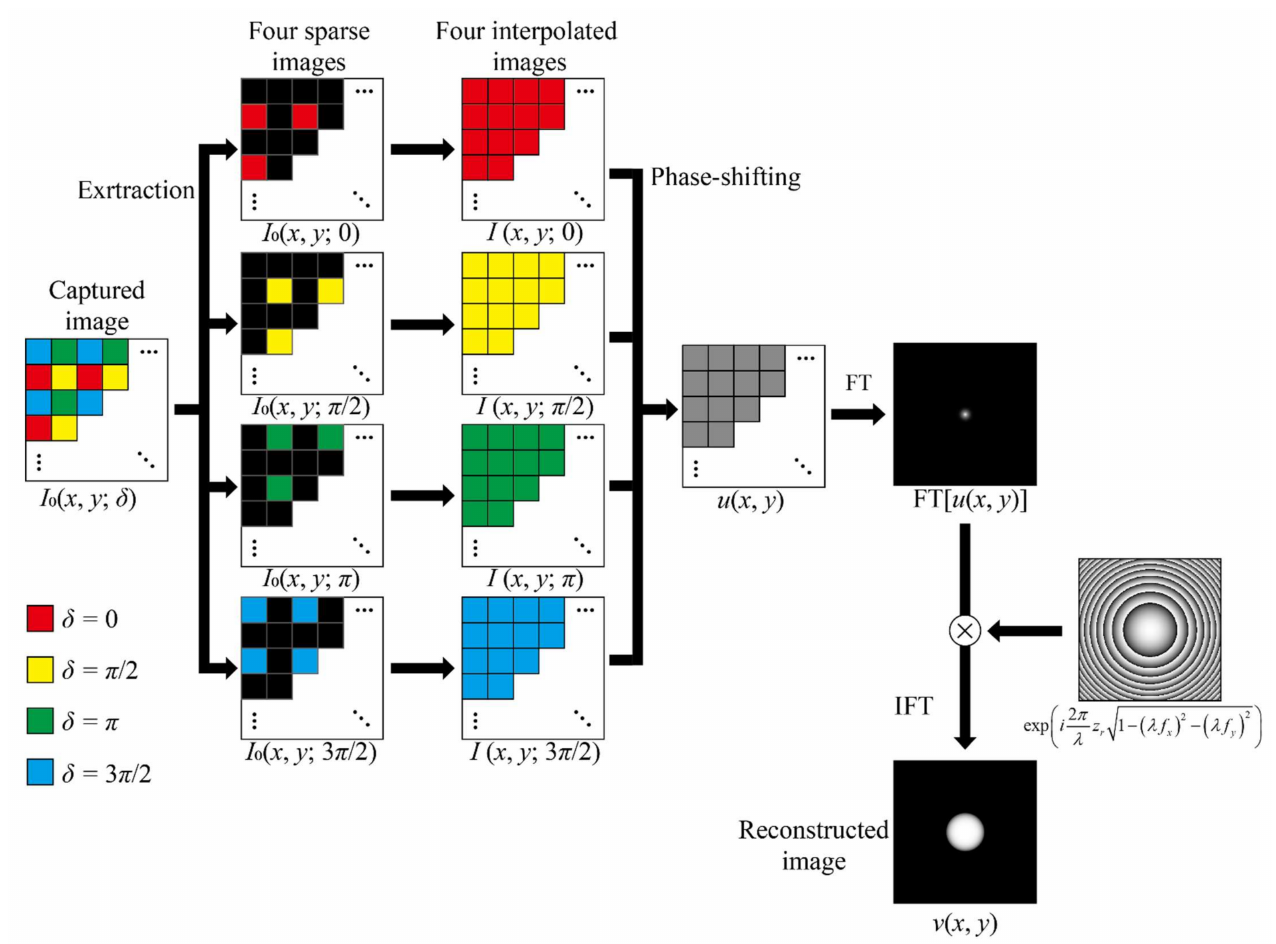
Figure 2. Conventional calculation procedure for parallel phase-shifting digital